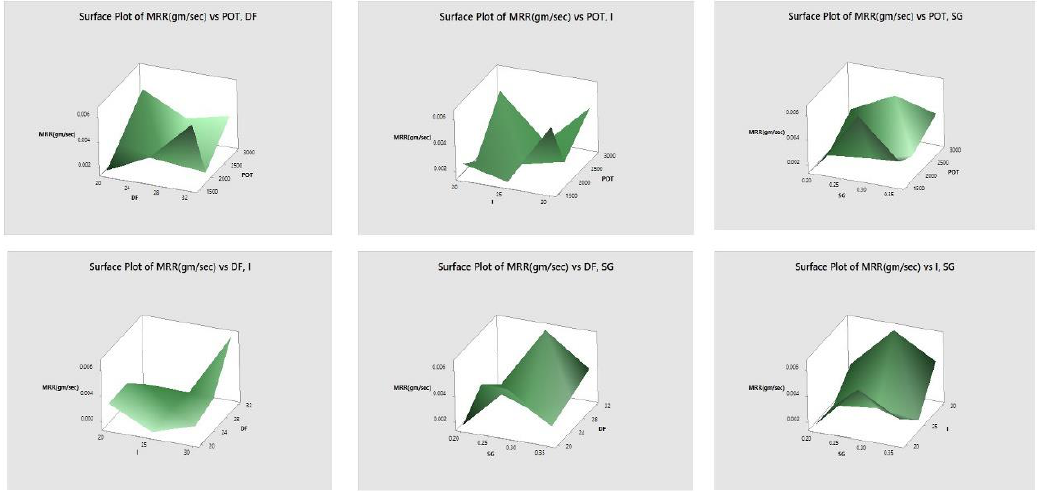
Fig. 9. Surface plot for the results of material removal